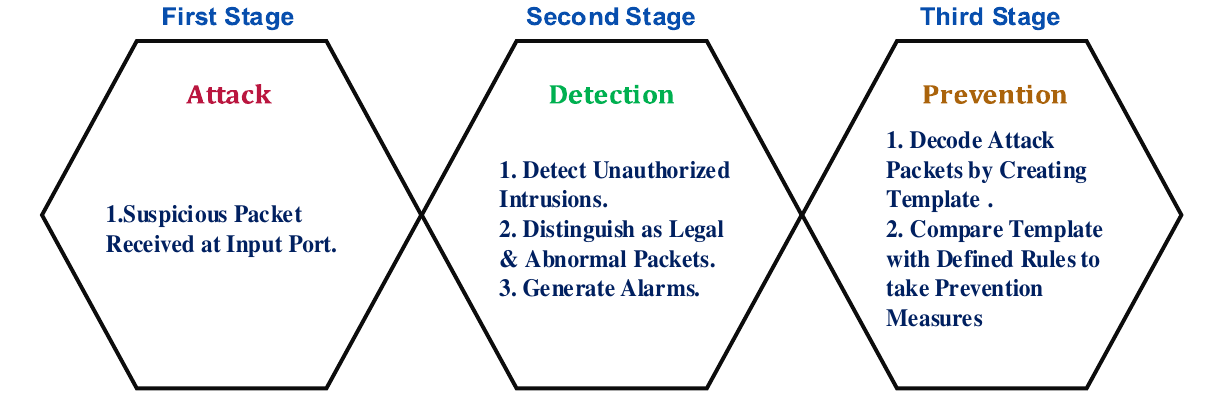
Fig. 3: Stages for proposed detection and prevention